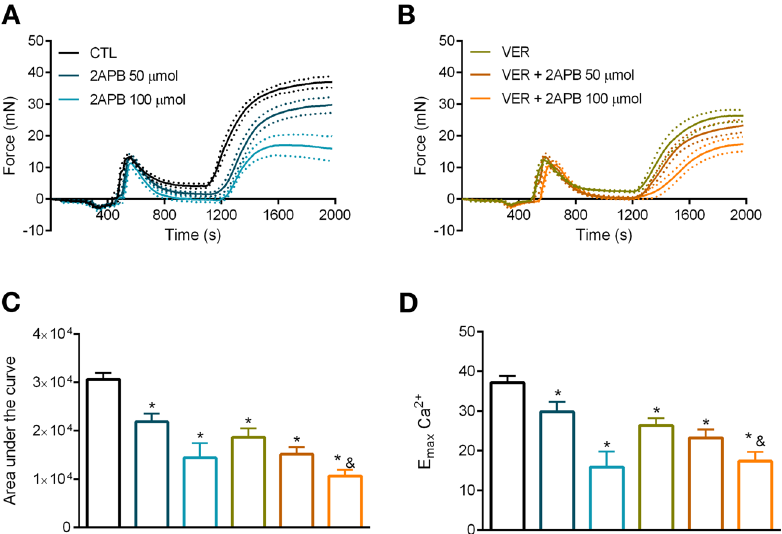
Figure 5. VER155008, an HSP70 inhibitor, does not augment the effect of a non-selective inhibitor of voltage- 2 + independent Ca channels in phenylephrine-stimulated aorta. Aortic rings were challenged with phenylephrine 2 + ( 10 µ mol/l ) in 0[ Ca ] Krebs’ solution in the presence of vehicle (CTL) or ( A ) 2-aminoethoxydiphenyl borate (2-APB) (50 and 100 µ mol/l, DMSO diluted) or ( B ) VER155008 ( 10 µ mol/l , DMSO diluted) as well as the combination of 2-APB and VER155008. Inhibitors were added after IP3r-mediated Ca 2 + concentration of Ca was restored after 10 min, and the force developed was evaluated for 15 min. ( C ) Area under the curve and ( D ) E max . Panels ( C , D ) use the same color scheme as panels ( A , B ). Data are expressed as mean ± SEM. n = 9 for CTL and VER and n = 6 for all other groups, * p < 0.05 vs. CTL and& p < 0.05 vs.